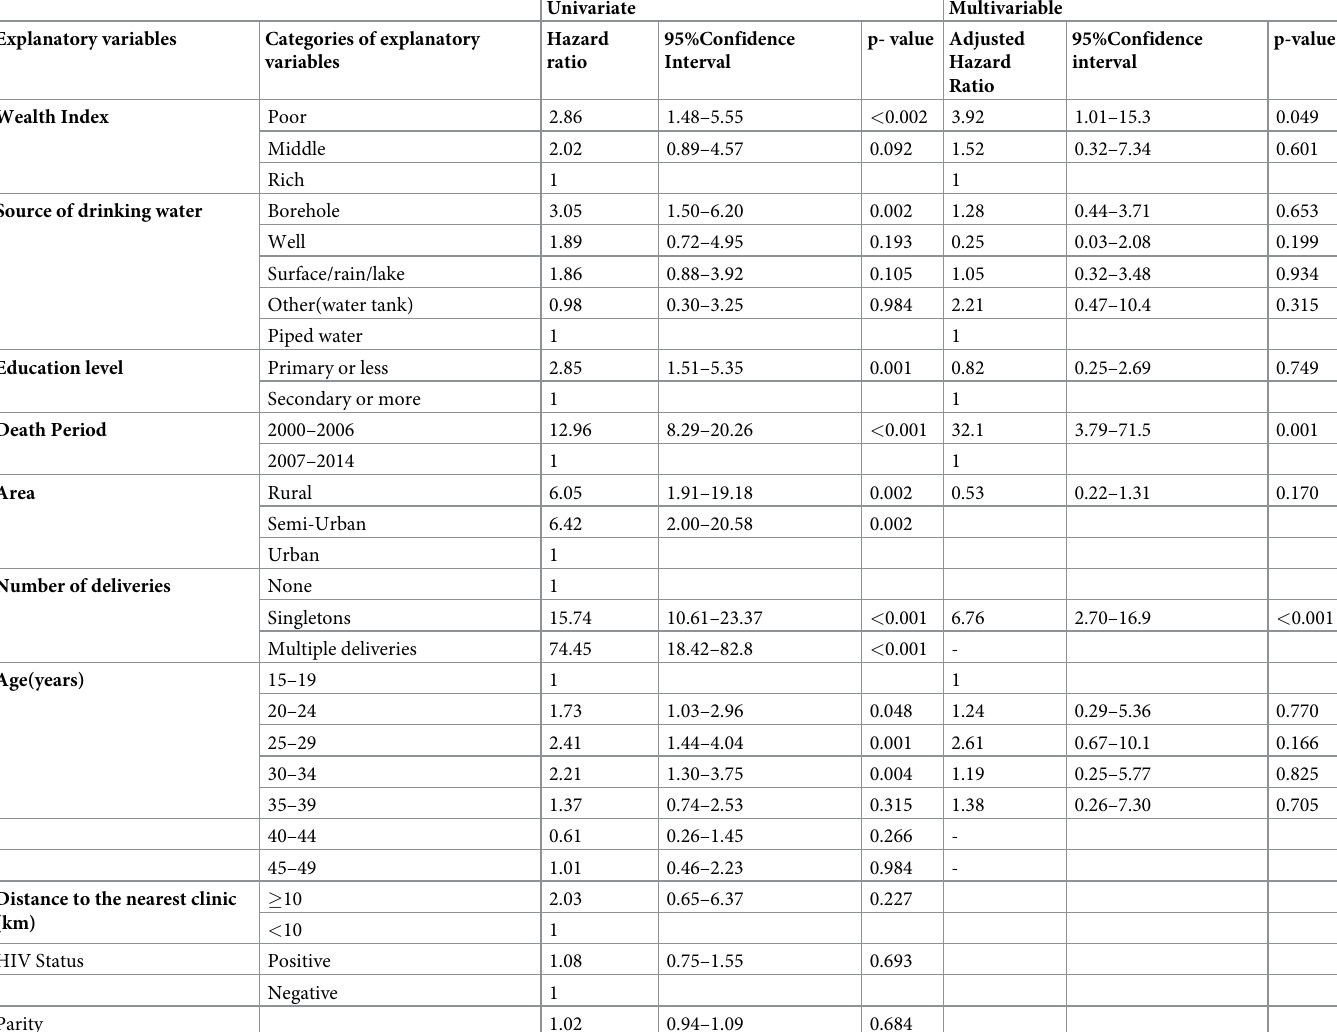
Table 2. Univariate and multivariate hazard ratios for risk factors associated with maternal mortality, Africa Health Research Institute (South Africa) using Cox proportional hazards